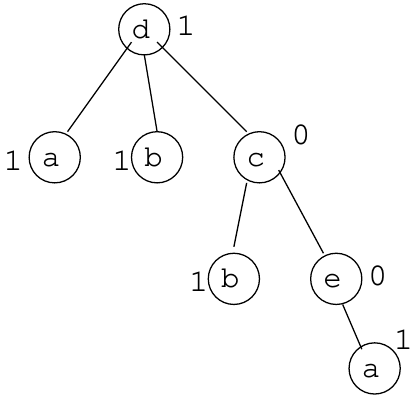
Figure 2. Trie representing a modified